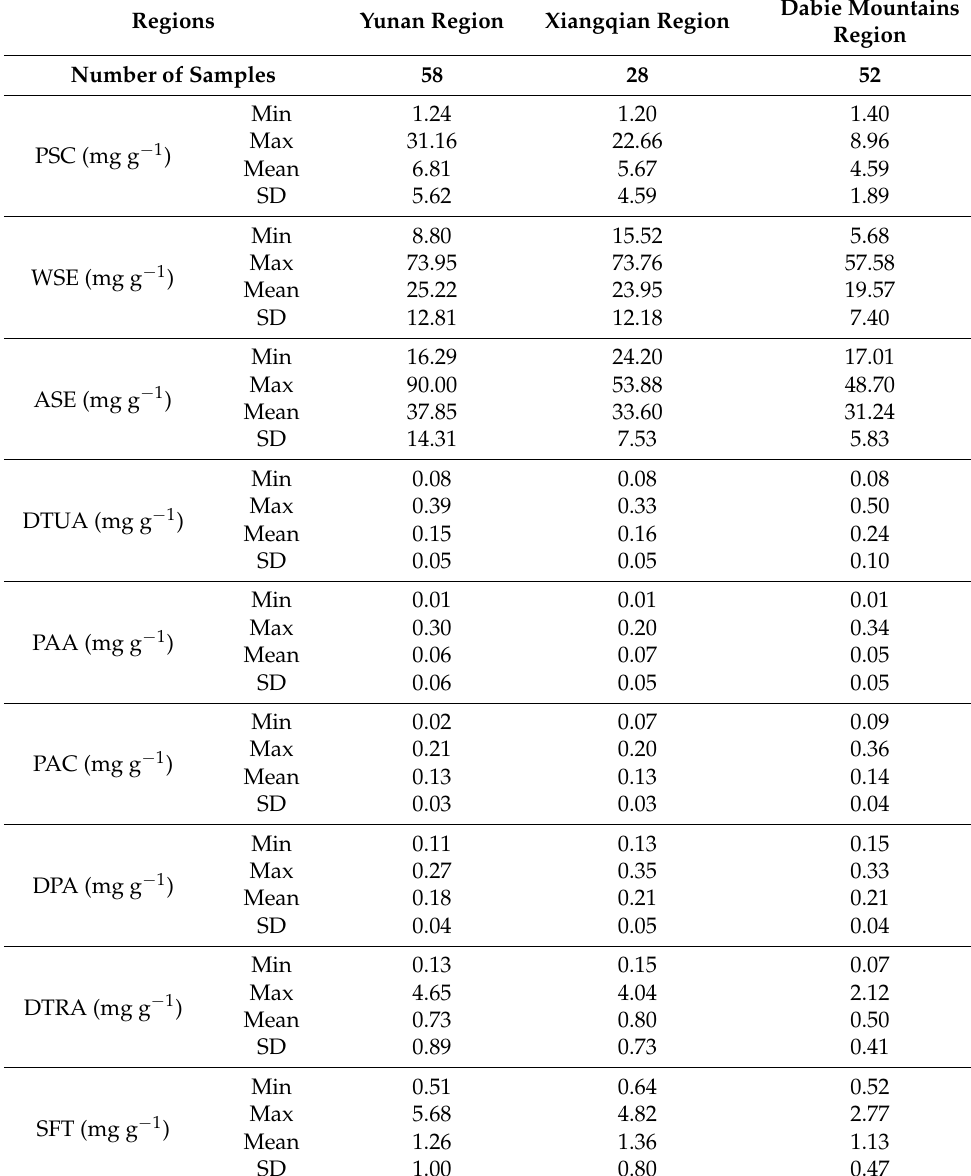
Table 2. Active contents of PC samples. Regions Yunan